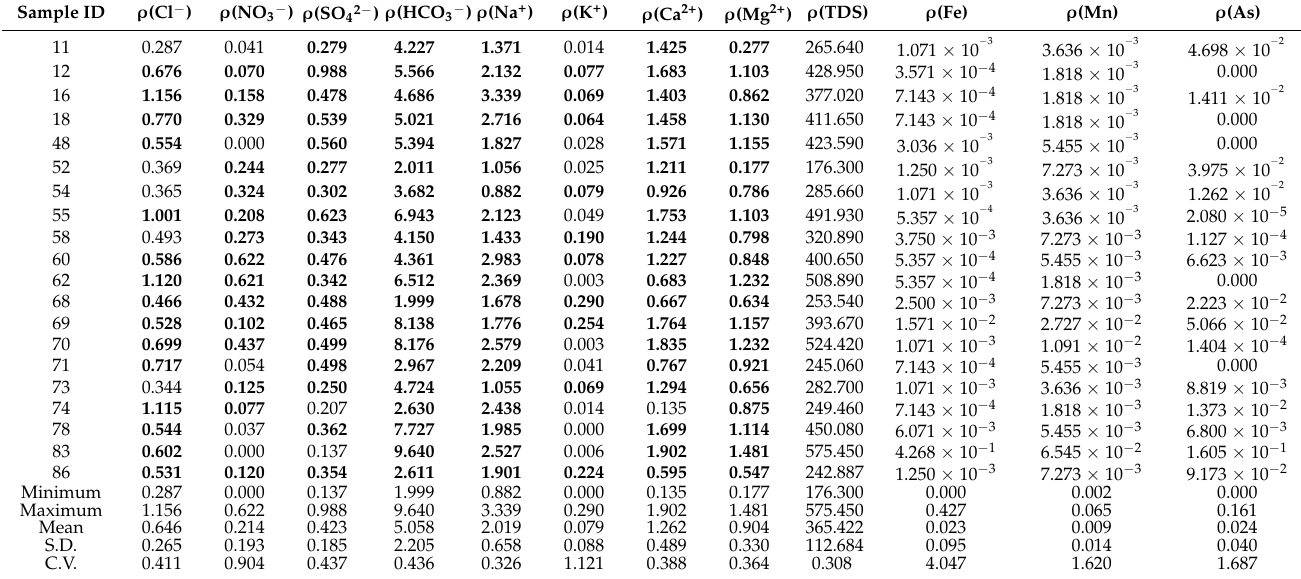
Table 1. Statistical characteristics of the chemical composition of phreatic water.